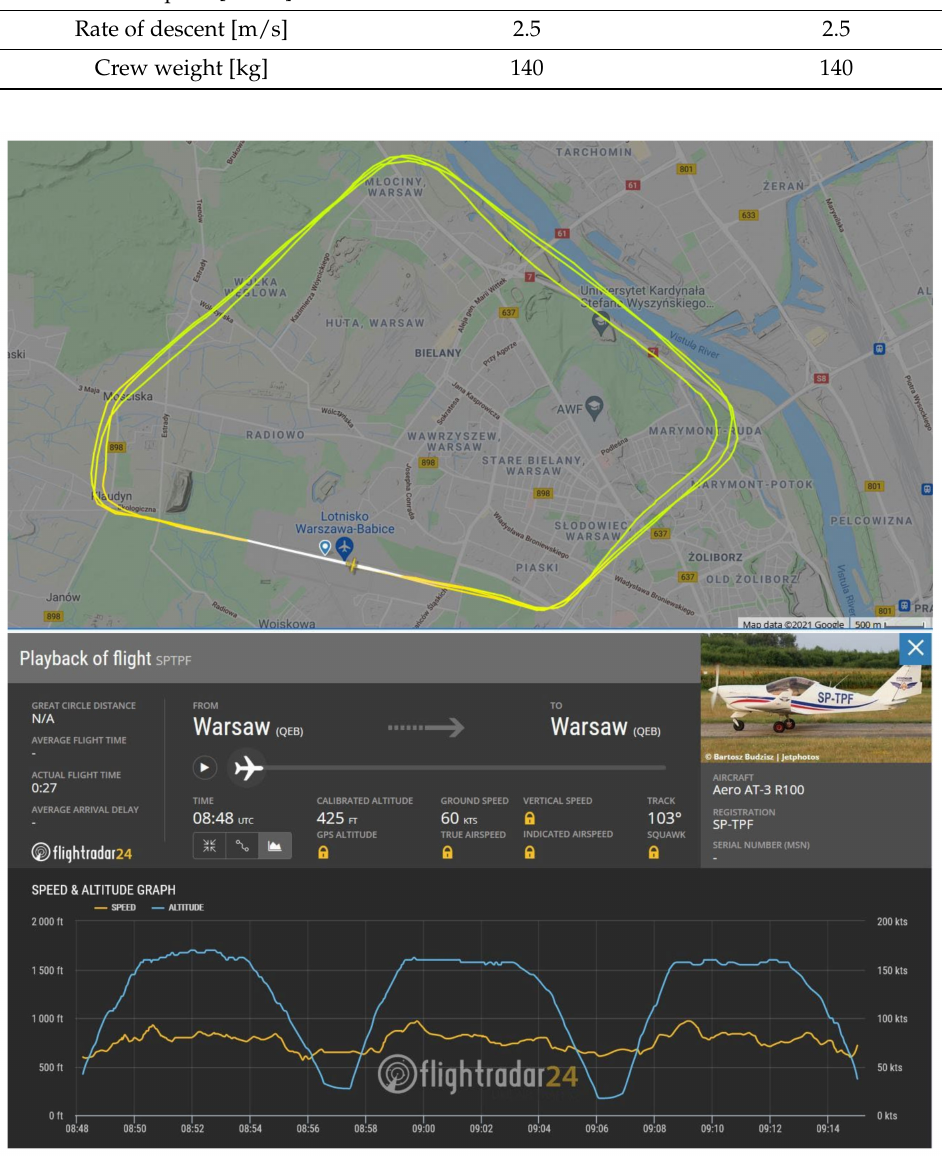
Figure 4. Real flight data from Flightradar24